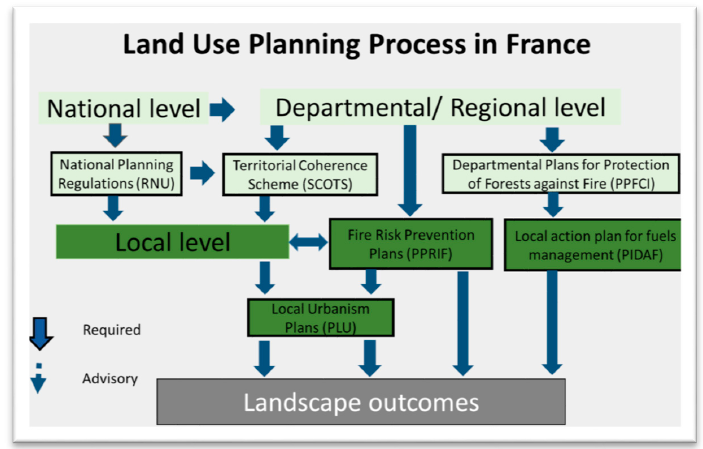
Figure 2. Schematic of land use planning to reduce wildfire hazard in France. The national government develops planning rules (RNUs), and the regional/departmental government mandates local fire hazard reduction plans (PPRIFs) to overlay land use plans (PLUs) developed by local government (PLU).